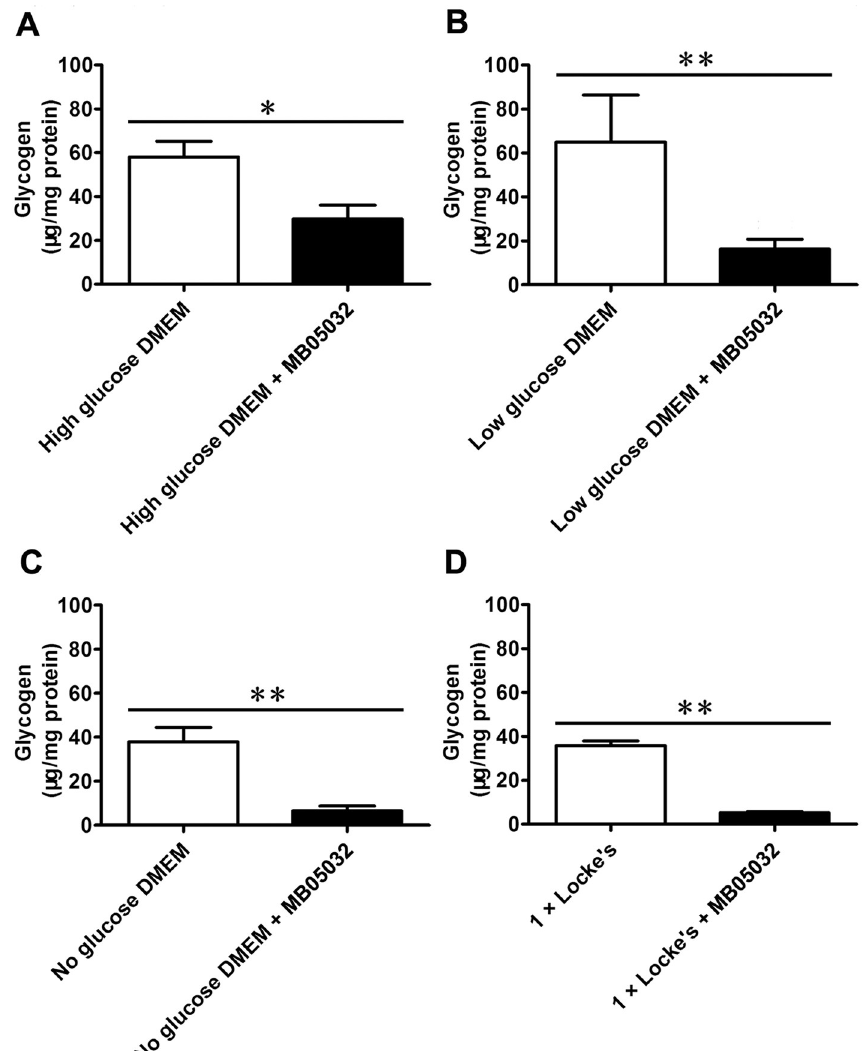
Fig 7. Glycogen level inside C . sinensis adults with or without MB05032 treatment. Adult flukes were respectively maintained on high, low, and no glucose DMEM (A, B, and C), as well as 1 × Locke’s (D) with or without the addition of MB05032. Glycogen level was detected at 24 h of feeding. Differences between two groups were evaluated by student’s t test. � P < 0.05 and �� P < 0.01 were represented as statistical significance.